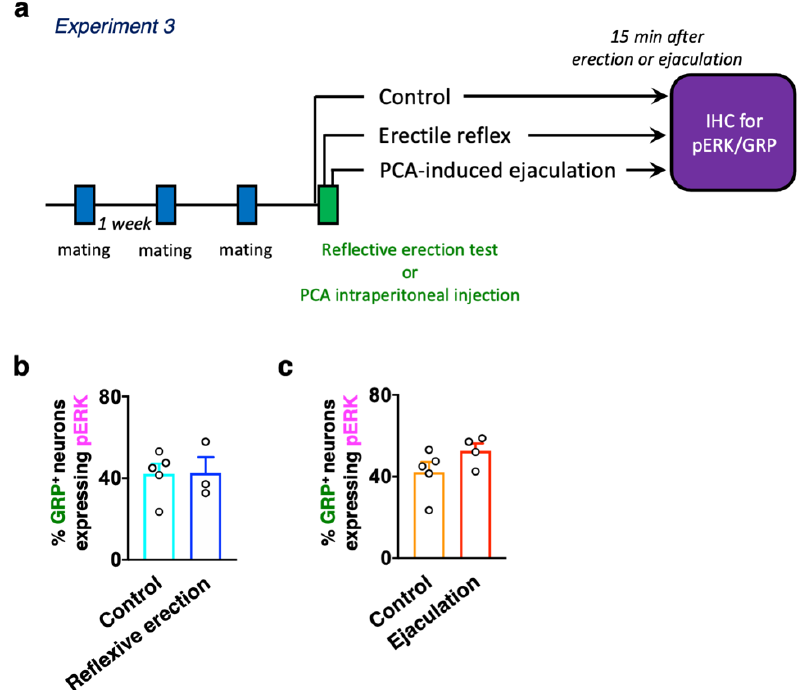
Figure 5. ( a ) Experimental paradigm of Experiment 3: evaluation of whether reflexive erection- or non-erection-induced ejaculation activates dXL neurons. ( b ) No statistical difference was noted in the ratio of activated spinal GRP-immunoreactive neurons between the Control ( n = 5) and Reflexive erection groups ( n = 3) (unpaired t -test, t 6 = 0.05). ( c ) There was no statistical difference in the ratio of activated spinal GRP-immunoreactive neurons between the Control ( n = 5) and Ejaculation groups ( n = 4) (unpaired t -test, t 7 = 1.60).